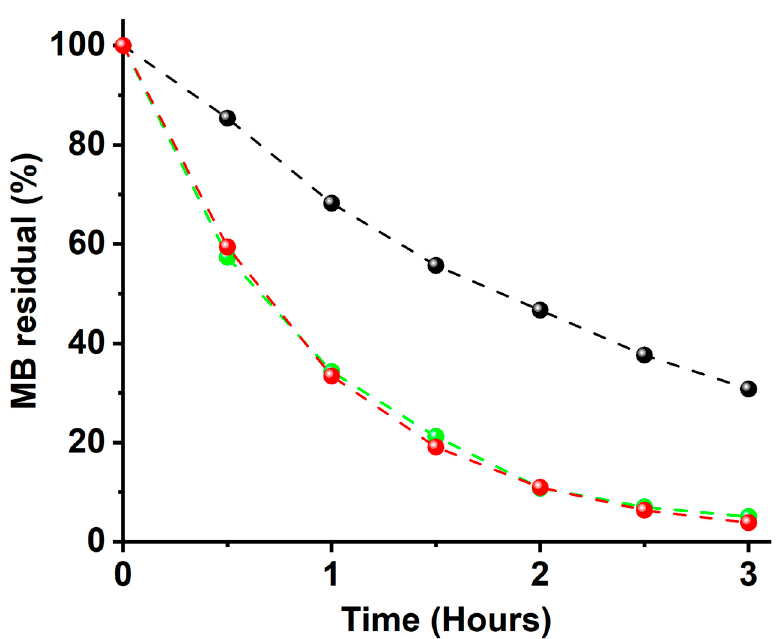
Figure 11. Kinetic curve obtained for MB photocatalytic degradation using bare TiO 2 (black line), 5-MBC-TiO 2 (green line), and 5-NBC-TiO 2 (red line) under boosted conditions.